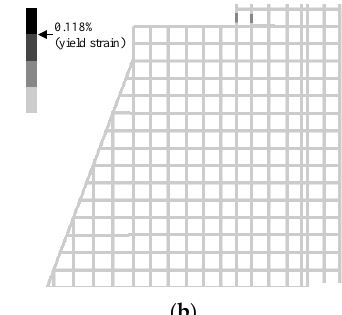
Figure 26. Comparison of reinforcing bar strain in the vertical direction of TYPE-A: ( a ) RC model; ( b ) RPCM model.